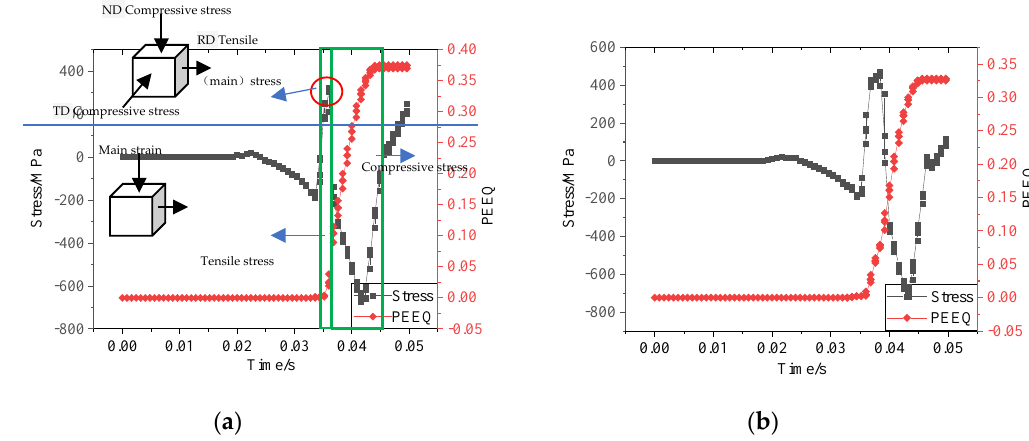
Figure 7. ( a ) Changes in stress and strain with time for a strip with a 0.25 mm grinding depth (first pass); ( b ) changes of stress and strain with time for a strip with a 0.5 mm grinding depth (first pass).